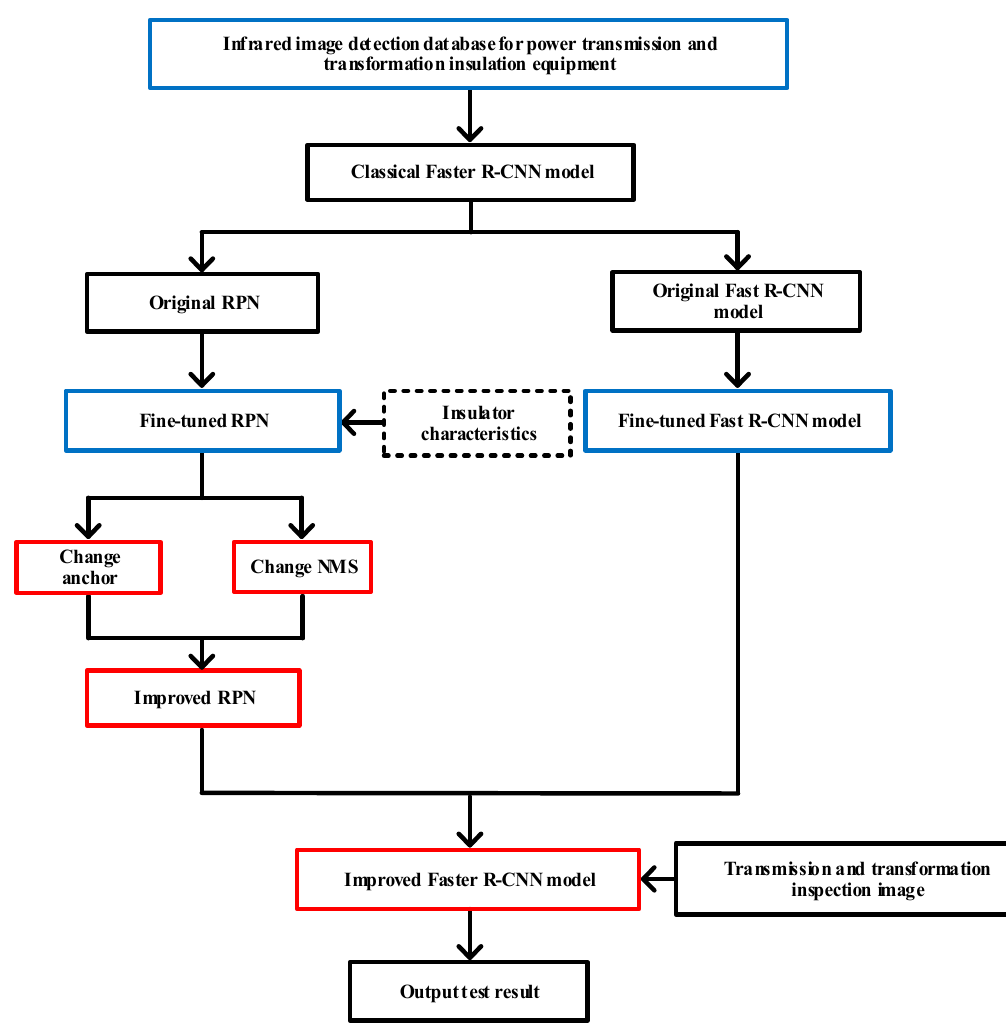
Figure 5. Framework of insulator images detection method based on improved the faster region-convolutional neural network (R-CNN).